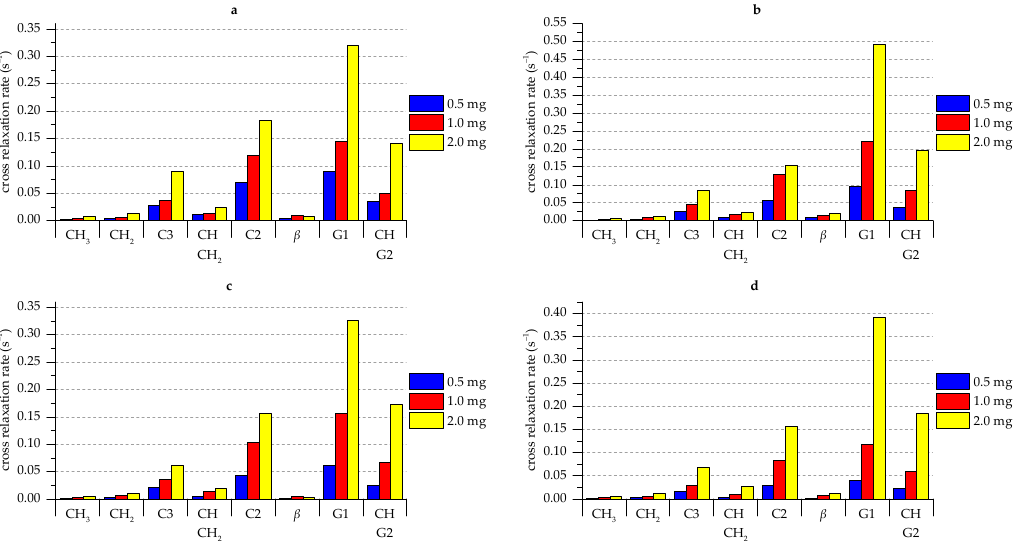
Figure A4. Cross relaxation rates of the aromatic protons (cross peak 1 ( a ), cross peak 2 ( b ), cross peak 3 ( c ), and cross peak 4 ( d )) of three different weighed amounts of tellimagrandin II 4 against different lipid protons with a mixing time of 0.3 s. The lipid proton assignations refer to Figure 5 and cross peak labels are defined in Chapter 3.3.